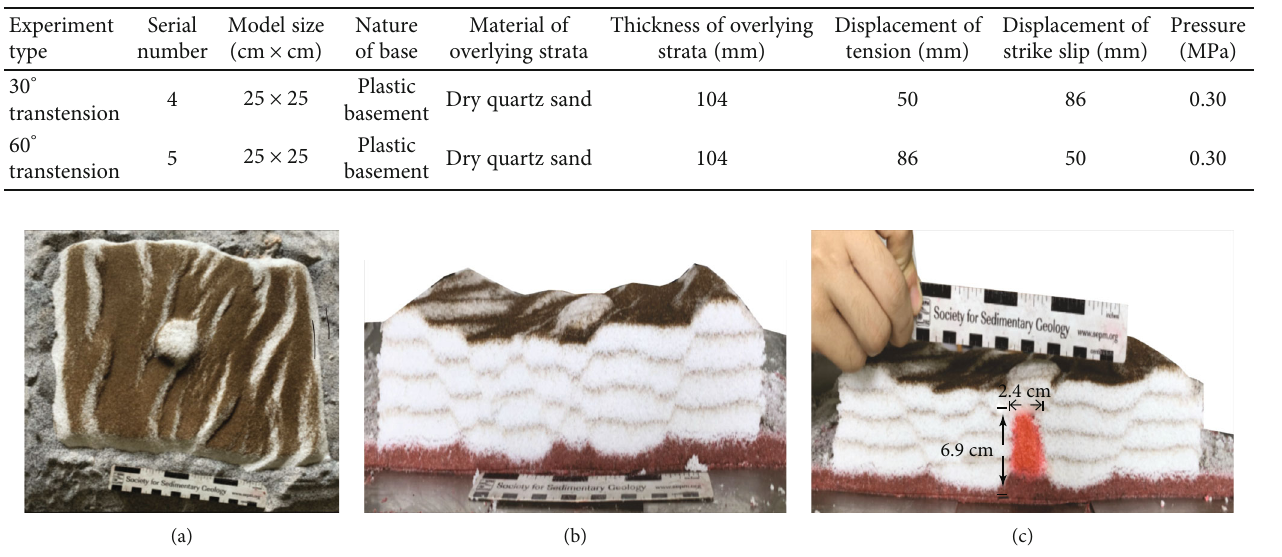
Figure 8: Simulation of formation of mud diapir in the background of 30 ° transtension. (a) More serious deformation of the model occurs in the background of 30 ° transtension, and a large number of fractures appear on the surface of the model; (b) lateral view of the outer edge of the model, which shows the undulation and deformation of the stratum, forming fractures; (c) central lateral view of the model, seeing a diapir upwell and punctured